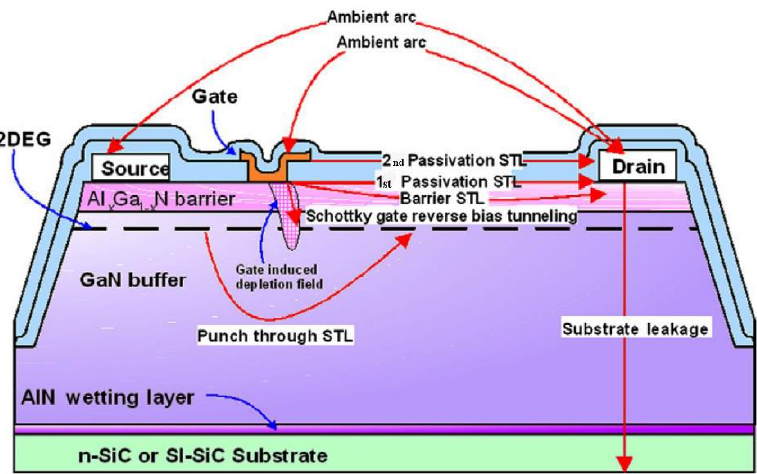
Figure 40. Illustration of most important sub-threshold current leakages (STL) and breakdown paths might appear during high voltage in GaN-based HEMTs. Reproduced with permission [170]. Copyright 2011, Elsevier.